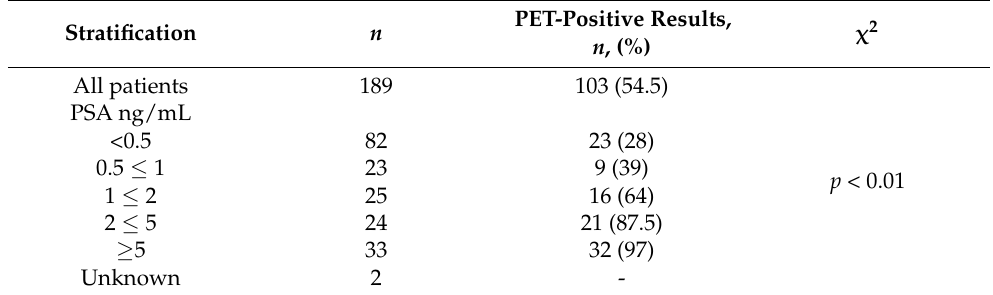
Table 4. 68 Ga-PSMA PET/CT detection rate dependent of PSA at recurrent disease, RP and RT combined.